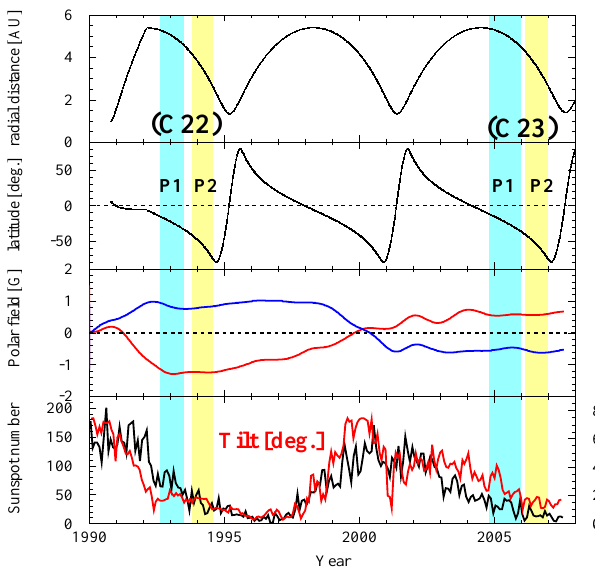
Fig. 2. From top to bottom: radial distance (in AU, first panel) and heliographic latitude (second panel) of the Ulysses orbit, solar mag- netic field strength of the southern (red line) and northern (blue line) polar regions (taken from http://quake.stanford.edu/ ∼ wso/) (third panel), as well as sunspot number (black, left hand axis) and the tilt angle (red, right hand axis) of the solar magnetic field (fourth panel). Marked by colour shading are the two periods C22 ( A> 0) and C23 ( A< 0) compared in this study, when Ulysses was at high southern heliographic latitudes during the solar cycles 22 and 23, respectively. The two subsections P1 (light blue) and P2 (yellow- green) within both time intervals indicate whether Ulysses was ex- posed to the slow (P1) and fast (P2) solar wind,